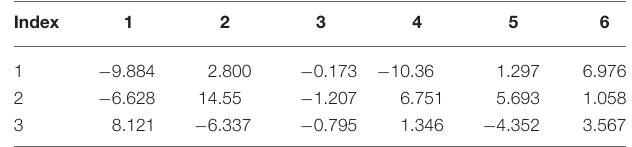
TABLE 8 | Internal strain tensor (Voigt notation) of N 1 for displacements in x, y, z (eV/Å).